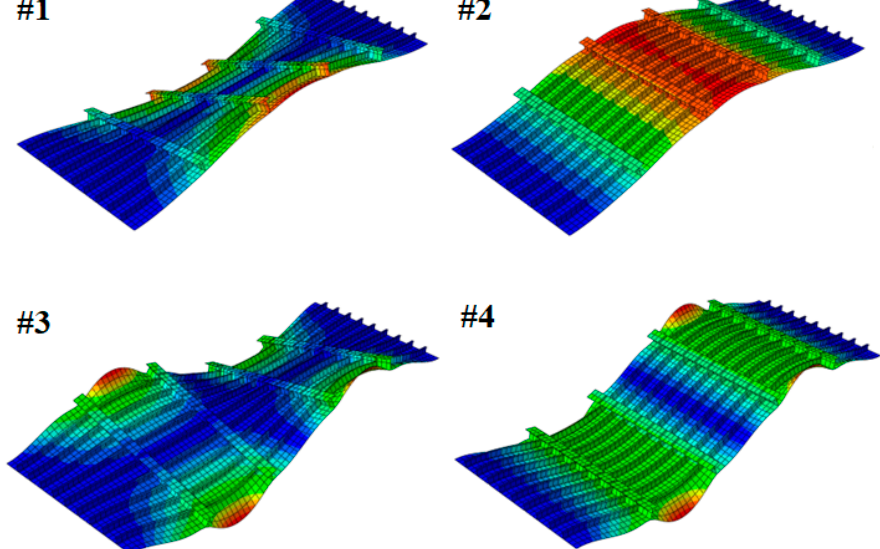
Figure 7. 1st–4th mode shapes of stiffened FE model.